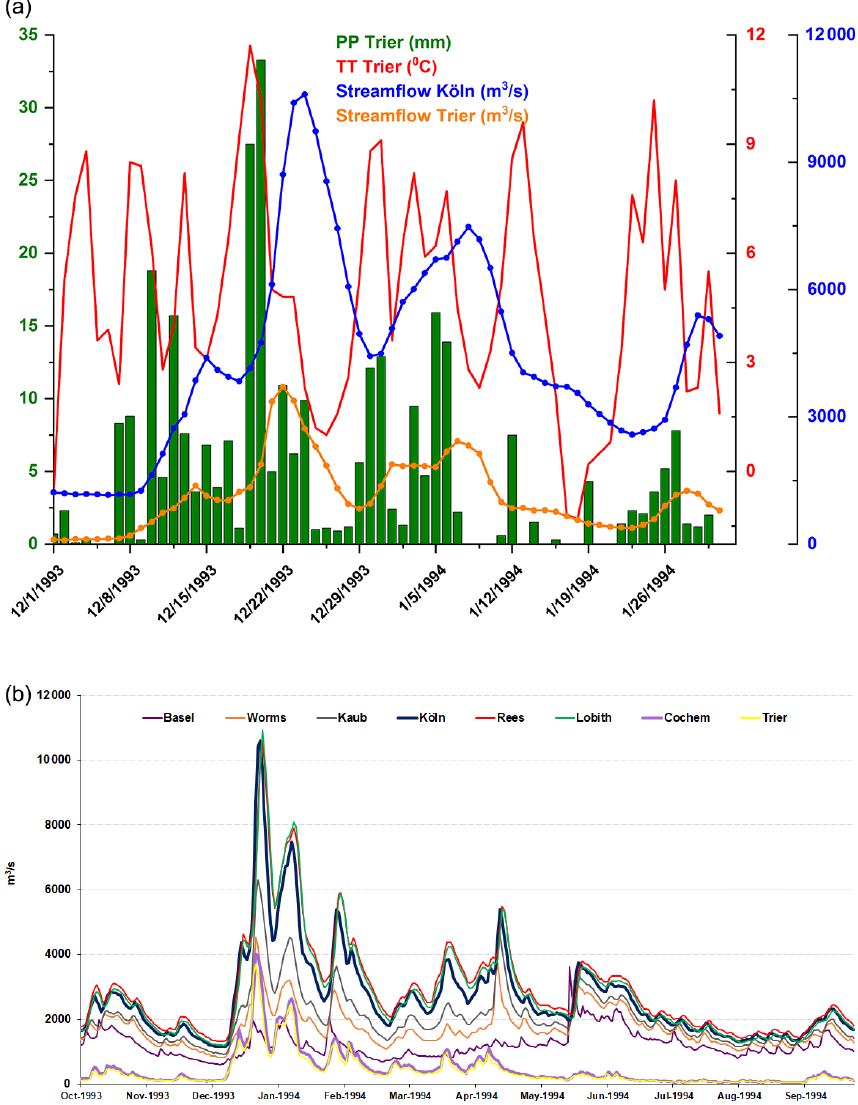
Figure 5. (a) Daily precipitation (green bars) at the Trier meteorological station, daily mean temperature (red line), daily streamflow at the Köln gauging station (blue line) and daily streamflow at the Trier gauging station (orange line) for the period 1 December 1993– 31 January 1994 (b) Daily streamflow at different gauging station along the Rhine (Basel, Worms, Kaub, Köln, Rees and Lobith) and Moselle rivers (Trier and Cochem) for the period 1 October 1993–30 September